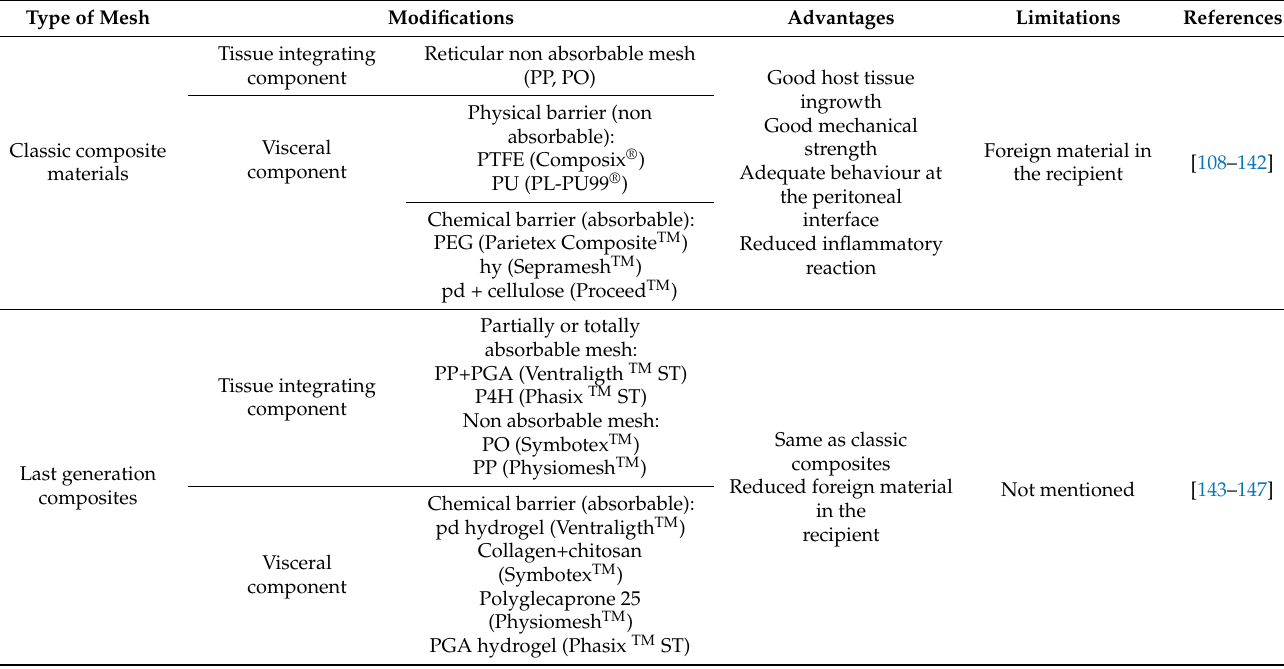
Table 2. Classification of the different types of composite meshes employed in hernia repair and the most representative modifications introduced (PP, polypropylene; PO, polyester; PTFE, polytetrafluoroethylene; PU, polyurethane; PEG, polyethylene glycol; hy, hyaluronate; pd, polydioxanone; PGA, polyglycolic acid; P4H, poly-4-hydroxybutirate). Type of Mesh Modifications